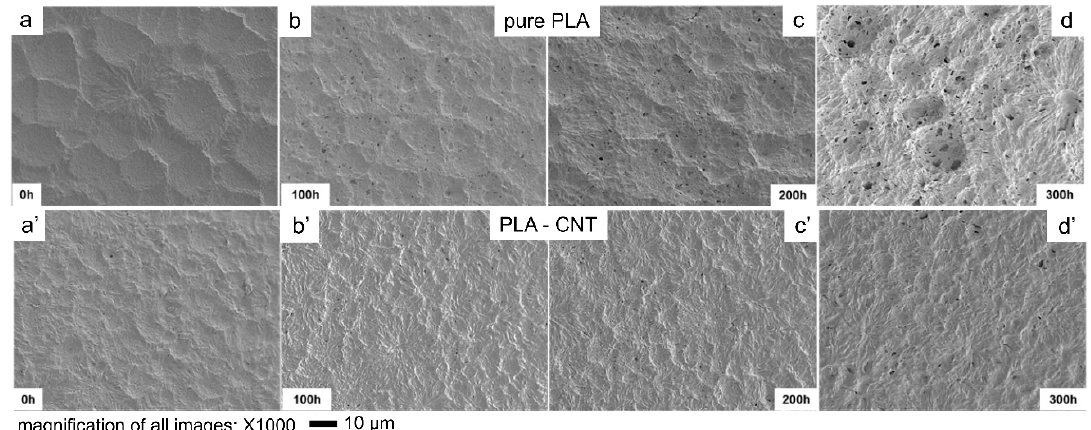
Figure 7. SEM results showing the surface morphology at 1000× magnification of ( a – d ) pure PLA, and ( a’ – d’ ) PLA-CNT after 300 h of degradation.